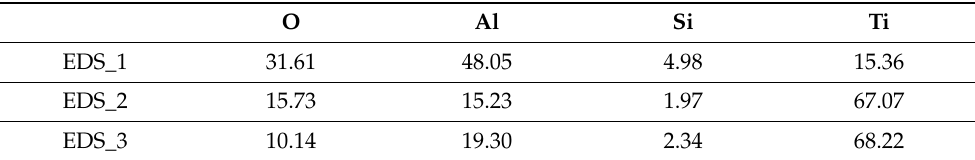
Table 3. Weight percentage compositional semi-quantitative analysis after EDS for the tribolayers transferred on the WC–6Co pins.